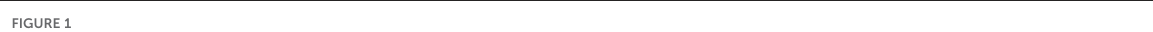
FIGURE1 transplantation, the patient received immunosuppressant drugs, including steroids, tacrolimus hydrate, and mycophenolic acid (mofetil); thereafter, these drugs were discontinued. Notably, no medications were introduced/stopped post transplantation. (B) The clinical trial flowchart of hiPSC-CM patches. Clinical-grade iPS cells were established and procured from CiRA (Kyoto University). The hiPSC-CM patches were manufactured in the cell processing center in Osaka University Hospital using the MCB cells generated in the Center for Gene and Cell Processing of Takara Bio Inc. (Kusatsu, Japan). The following quality inspections were performed during the manufacturing process: QC1: Quality check of the MCB (7). The detailed procedure of the generation of MCB is described elsewhere (7). QC2: viability, purity of cardiomyocytes, sterility, mycoplasma testing, and endotoxin testing (Supplementary Table 1). CAG, coronary angiography; RCA, right coronary artery; LCX, left circumflex coronary artery branch; LAD, left anterior descending coronary artery; PCI, percutaneous coronary intervention; LMT, left main coronary trunk; AV, atrioventricular node branch; ACS, acute coronary syndrome; IABP, intra-aortic balloon pumping; PCPS, percutaneous cardiopulmonary support; and ACE, angiotensin-converting enzyme; iPS, induced pluripotent stem; hiPSC-CM, human induced pluripotent stem cell-derived cardiomyocyte; MCB, master cell